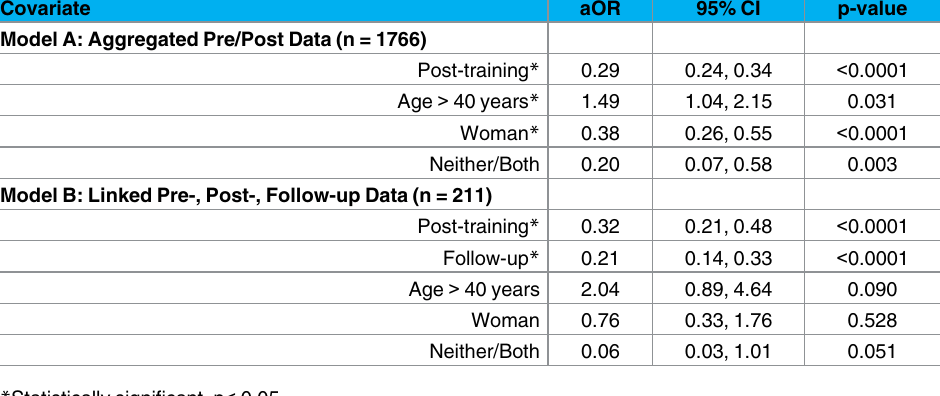
Table 6. Multivariable ordinal logistic regression models of factors associatedwith attitudes toward gender variance. Covariate aOR 95% CI p-value Model A: Aggregated Pre/Post Data (n = 1766)